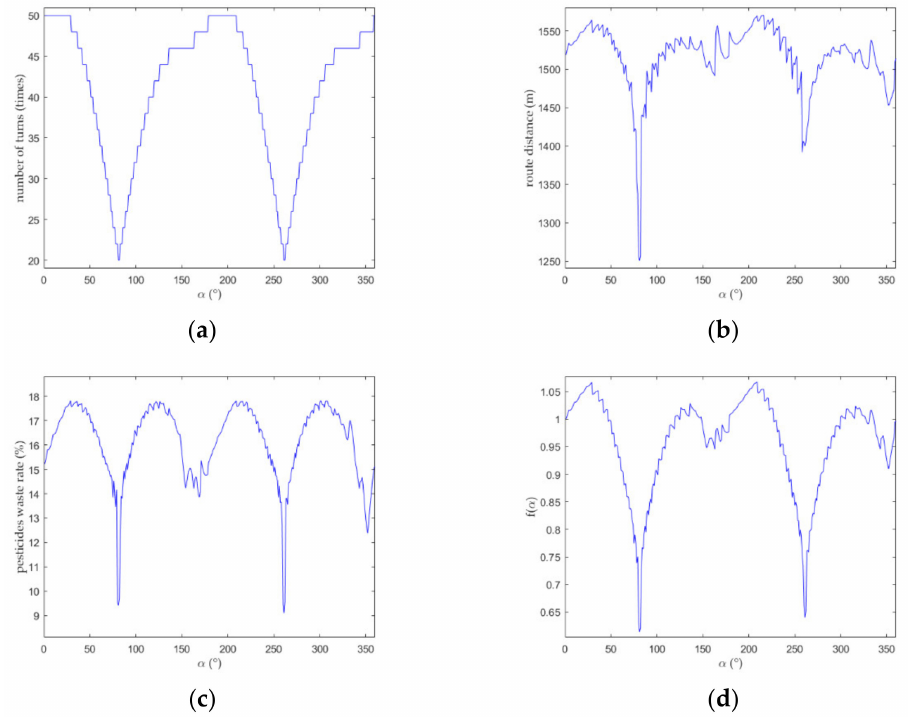
Figure 7. ( a ) Relationship between the number of turns and initial heading angle for different routes; ( b ) relationship between route distance and initial heading angle for different routes; ( c ) relationship between pesticide waste rate and initial heading angle for different routes; ( d ) relationship between evaluation function and initial heading angle for different